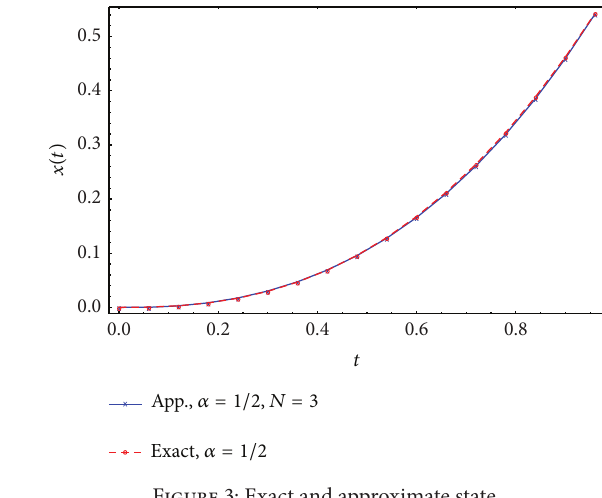
Figure 3: Exact and approximate state.